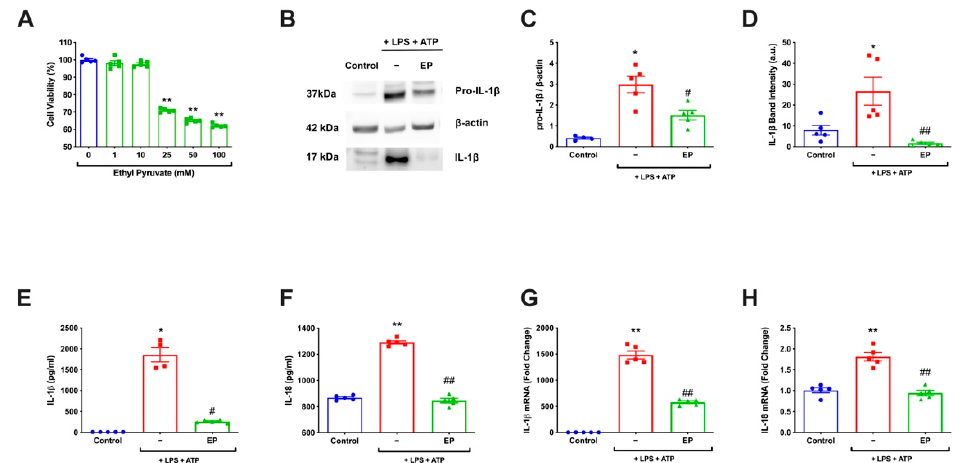
Figure 1. EP reduced mRNA and protein levels of IL-1 β and IL-18. N9 microglial cells were pretreated with EP (10 mM) for one hour, then treated with LPS (1 µ g/mL) for four hours and ATP (5 mM) for 1 h. ( A ) The toxicity of EP was determined. ( B – D ) Protein levels of pro-IL-1 β and secreted IL-1 β were reduced by EP compared to LPS- and ATP-induced cells. ( E , F ) The suppressor effect of EP on secreted IL-1 β and IL-18 was measured with ELISA. ( G , H ) mRNA levels of IL-1 β and IL-18 reduced by EP pre-treatment compared to LPS and ATP induction group. Data are presented as mean ± S.E.M, n = 5. * p < 0.05, ** p < 0.01 compared to control and # p < 0.05, ## p < 0.01 compared to LPS- and ATP-induced cells.